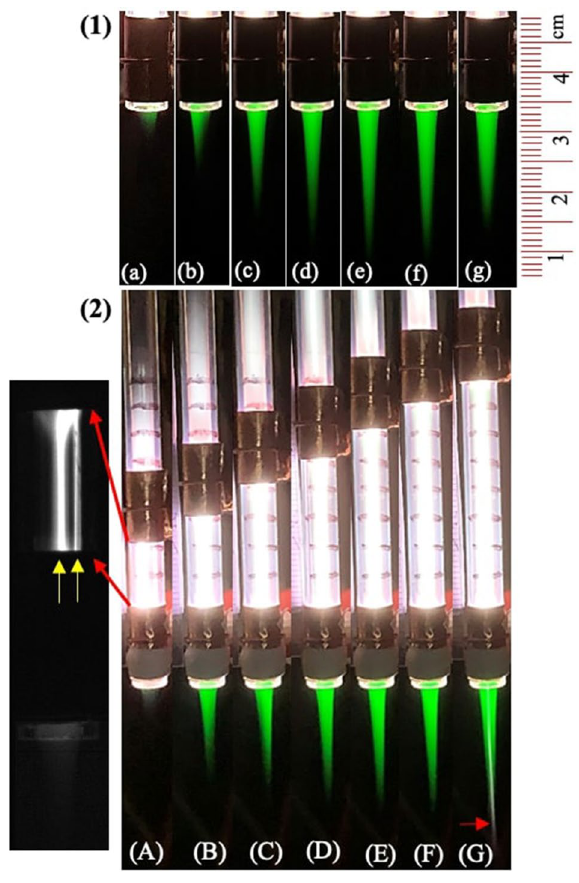
Figure 5. (1) Typical snapshots of the plasma jet at ( a ) 2 sL/min ( b ) 3 sL/min ( c ) 4 sL/min ( d ) 5 sL/min ( e ) 6 sL/min ( f ) 7 sL/min and ( g ) 8 sL/min. (2) Photograph of the APPJ at electrode gap ( A ) 10 mm, ( B ) 15 mm,